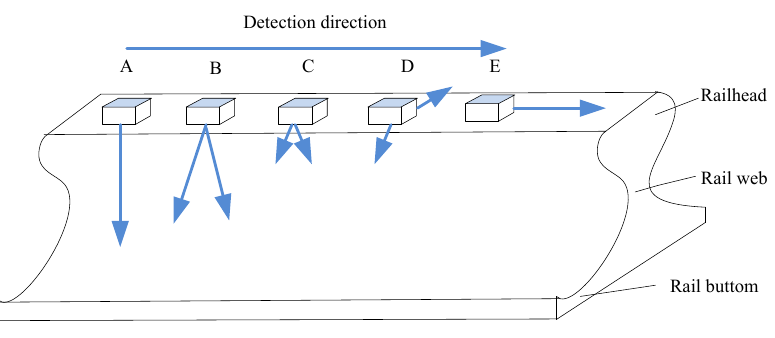
Figure 16. Both the cumulative average method and cross-correlation detection method were used to realize the processing of the echo signals. The detection system achieved a standout denoising effect with high speed and realized the overall detection of the rails. Figure 16. Placement of EMATs on the railhead.